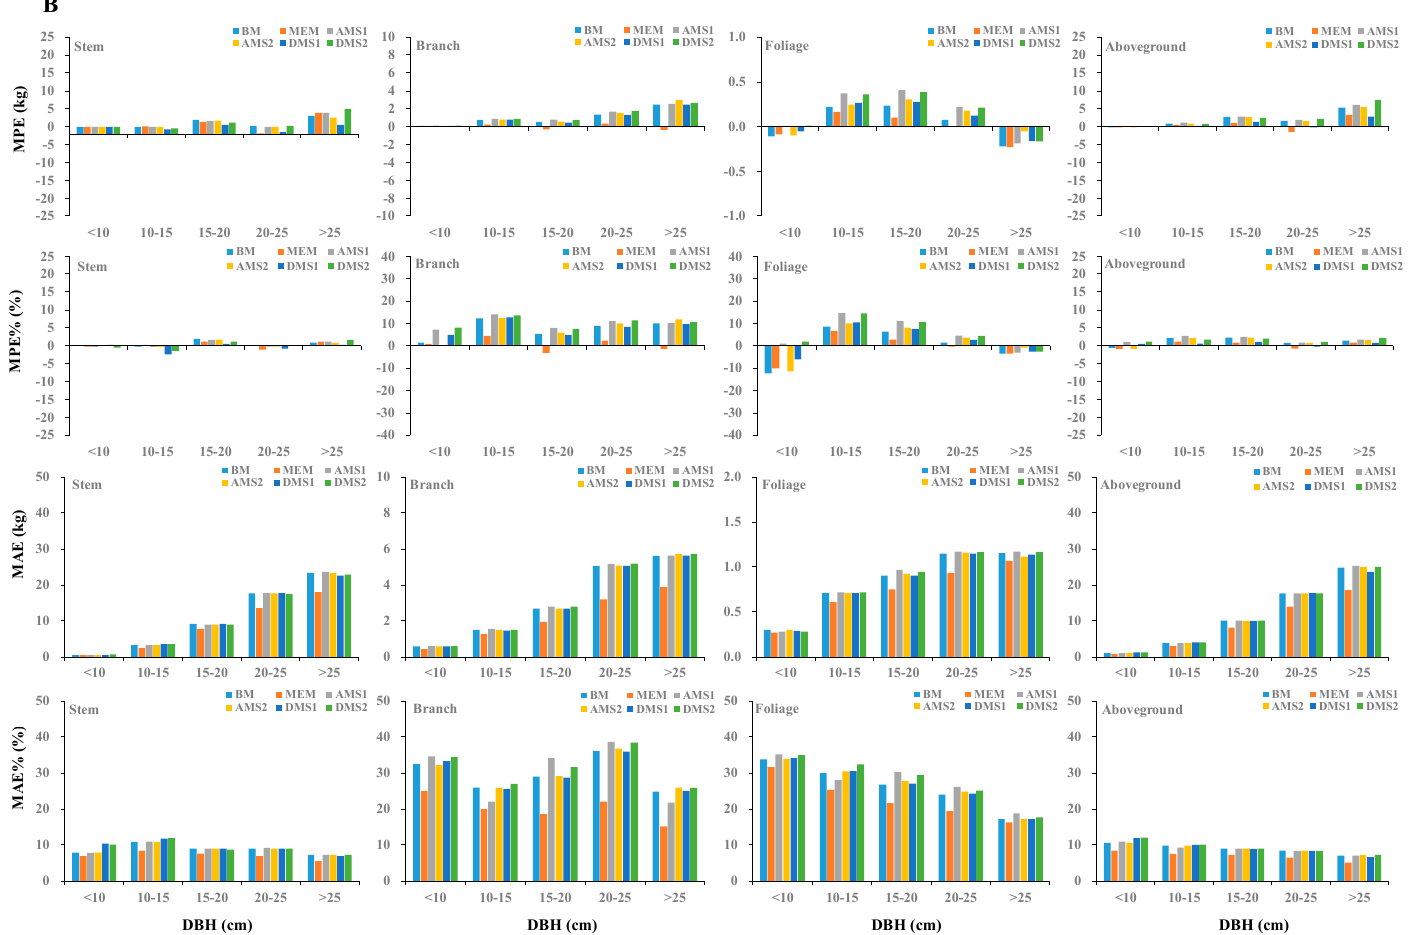
Figure 4. Comparison of model performance for the six biomass modeling approaches based on DBH ( A ) and combination of DBH and H ( B ) across diameter classes by the mean prediction error (MPE), mean prediction error percent (MPE%),mean absolute error (MAE), and mean absolute percent error (MAE%) in aboveground and components biomass.